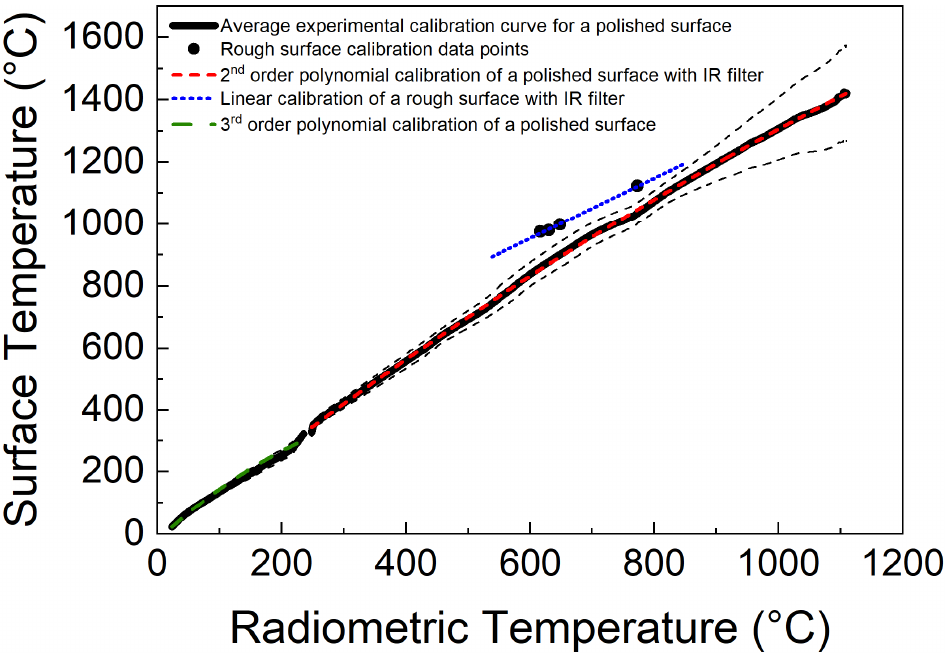
Figure 12. Experimental calibration data and polynomial temperature calibration curves for commercially pure titanium with polished and rough surfaces and with and without an attenuation IR filter. The average experimental calibration data is represented with their respective standard error of the means as dashed lines.